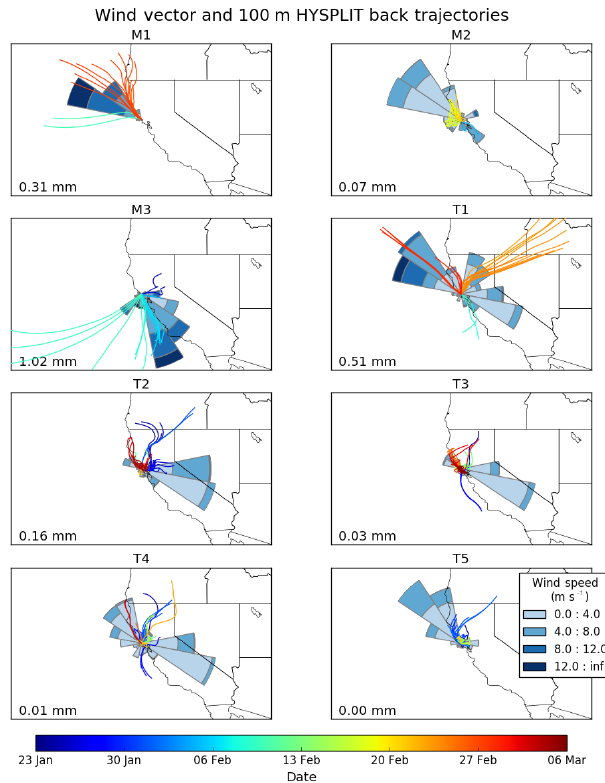
Figure 5. Meteorological overview for each cluster from the eight- cluster K -means classification. HYSPLIT 24h back trajectories are shown for each time stamp associated with the cluster and colored by the date of arrival at the receptor. Wind rose plots are shown for all BML local 10m wind direction and velocity measurements for each time stamp associated with the cluster. Mean values for 24h accumulated precipitation along the trajectory are included in the lower left for each